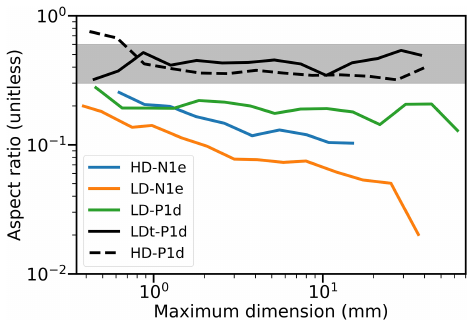
Figure 2. Aspect ratios of various aggregate types available in the scattering database as a function of their maximum dimensions. The aspect ratio is defined as the ratio of the sizes of the minor axes to the major axes. The grey shading between 0.3 and 0.6 represents the typical range of snow aggregate aspect ratios observed in nature (Garrett et al., 2015; Jiang et al.,